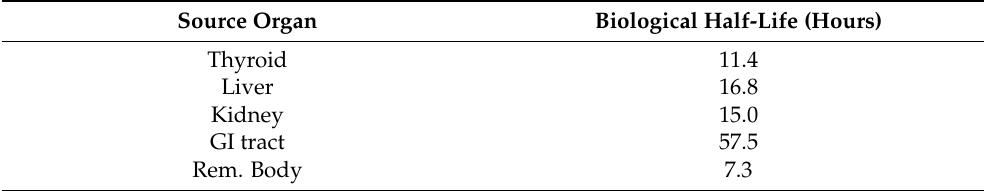
Table 2. Terminal biological half-life of source organs determined by exponential fit to the last two data points ( t 4 and t 5 ) in Figure